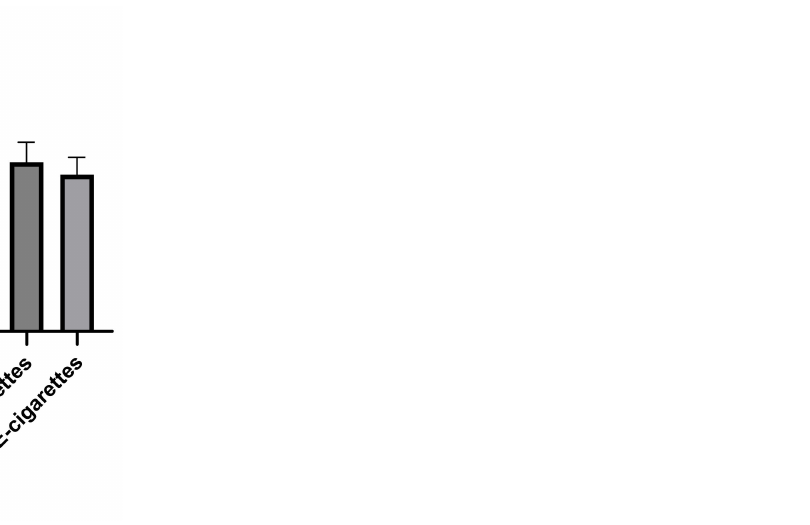
Figure 2. Concentration of hypoxanthine in groups of e-cigarettes users, traditional cigarettes smokers and non-smokers.